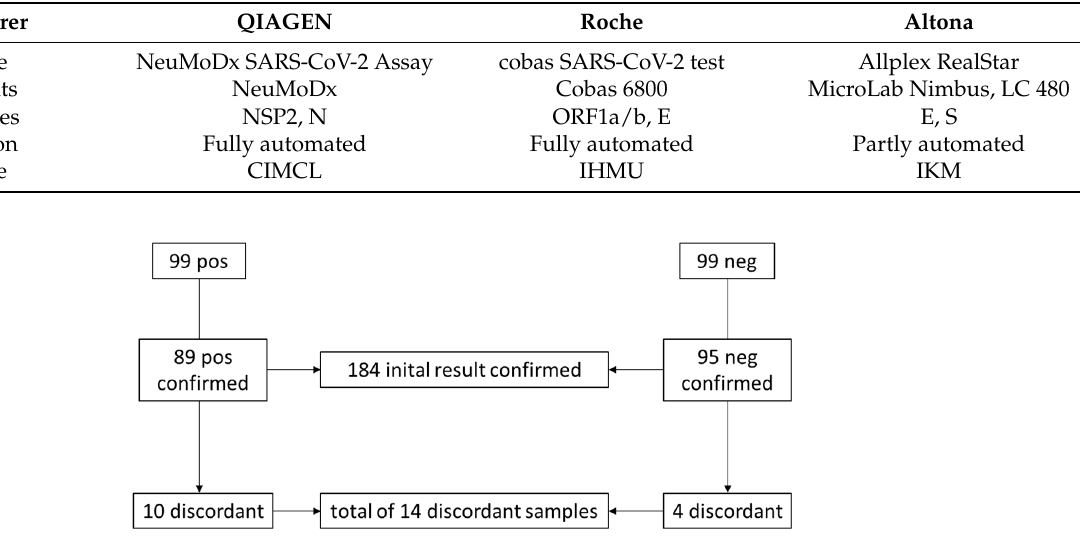
Table 1. Characteristics of all tests used in this study.